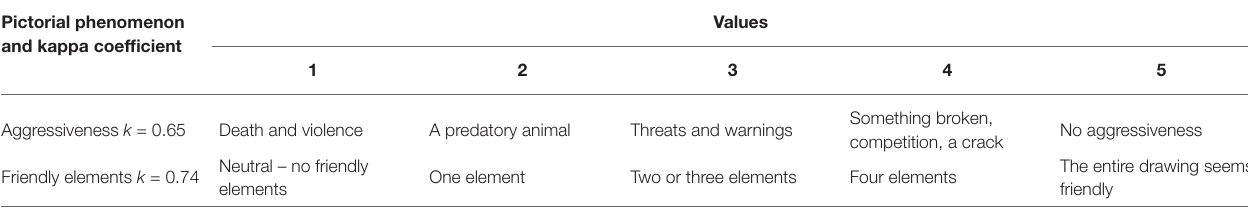
TABLE 2 | Phenomena included in the closeness measure for joint drawings that consisted of one cohesive